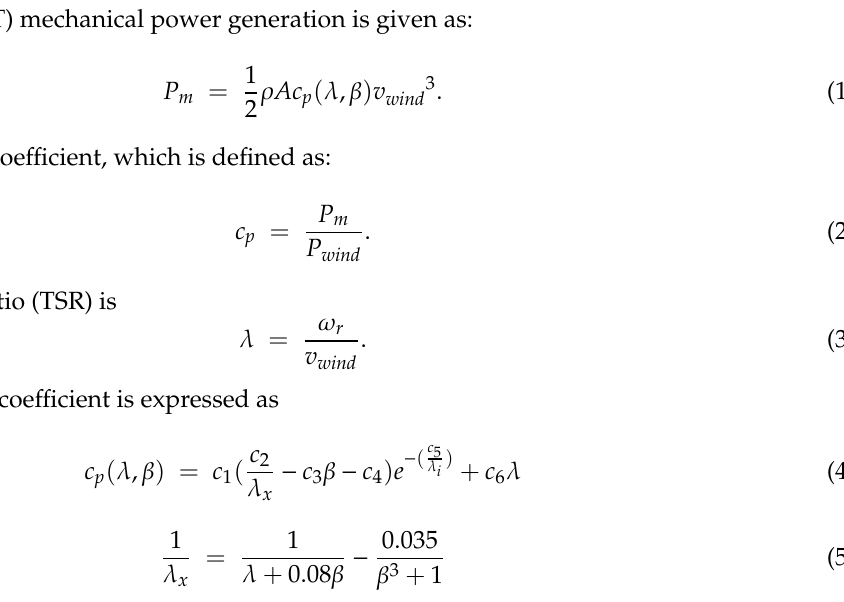
Figure 2. Double-fed induction generator (DFIG) wind turbine.